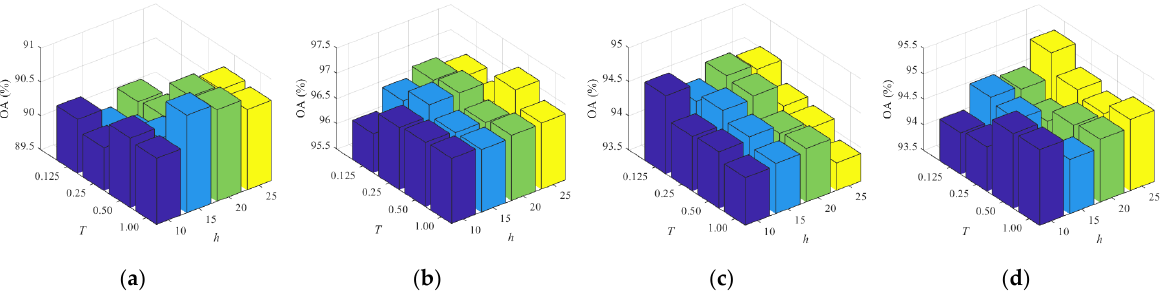
Figure 16. Classification accuracies over different values of T and h : ( a ) the Indian Pines dataset; ( b ) the Pavia University dataset; ( c ) the Houston dataset; ( d ) the Chikusei dataset.